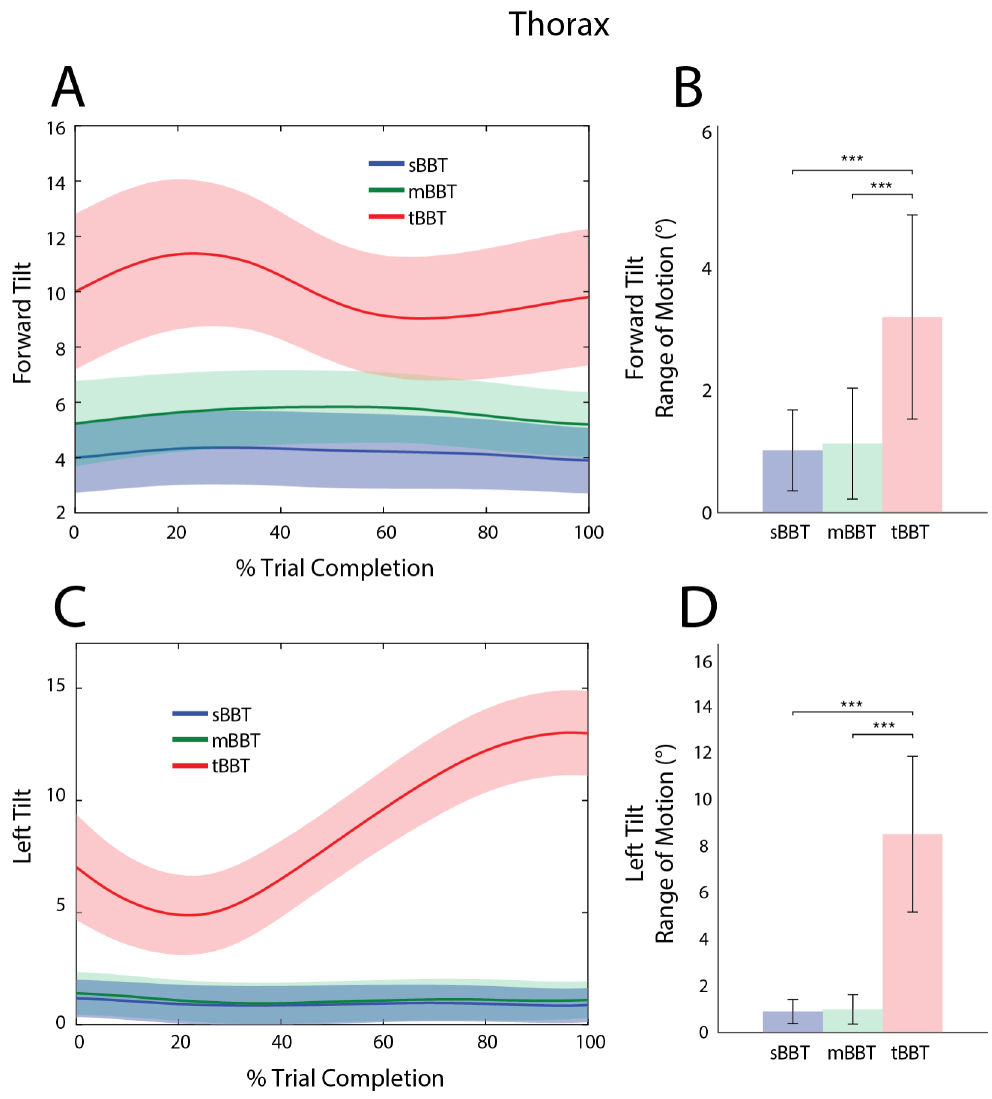
Fig 6. Kinematic trajectoriesand RoM of the thorax. Kinematictrajectories and RoM of the thorax for the sBBT (blue), mBBT (green), and tBBT (red). (A) Forward tilt and (C) left tilt trajectories for each test. (B) Forward tilt RoM and (D) left tilt RoM for each